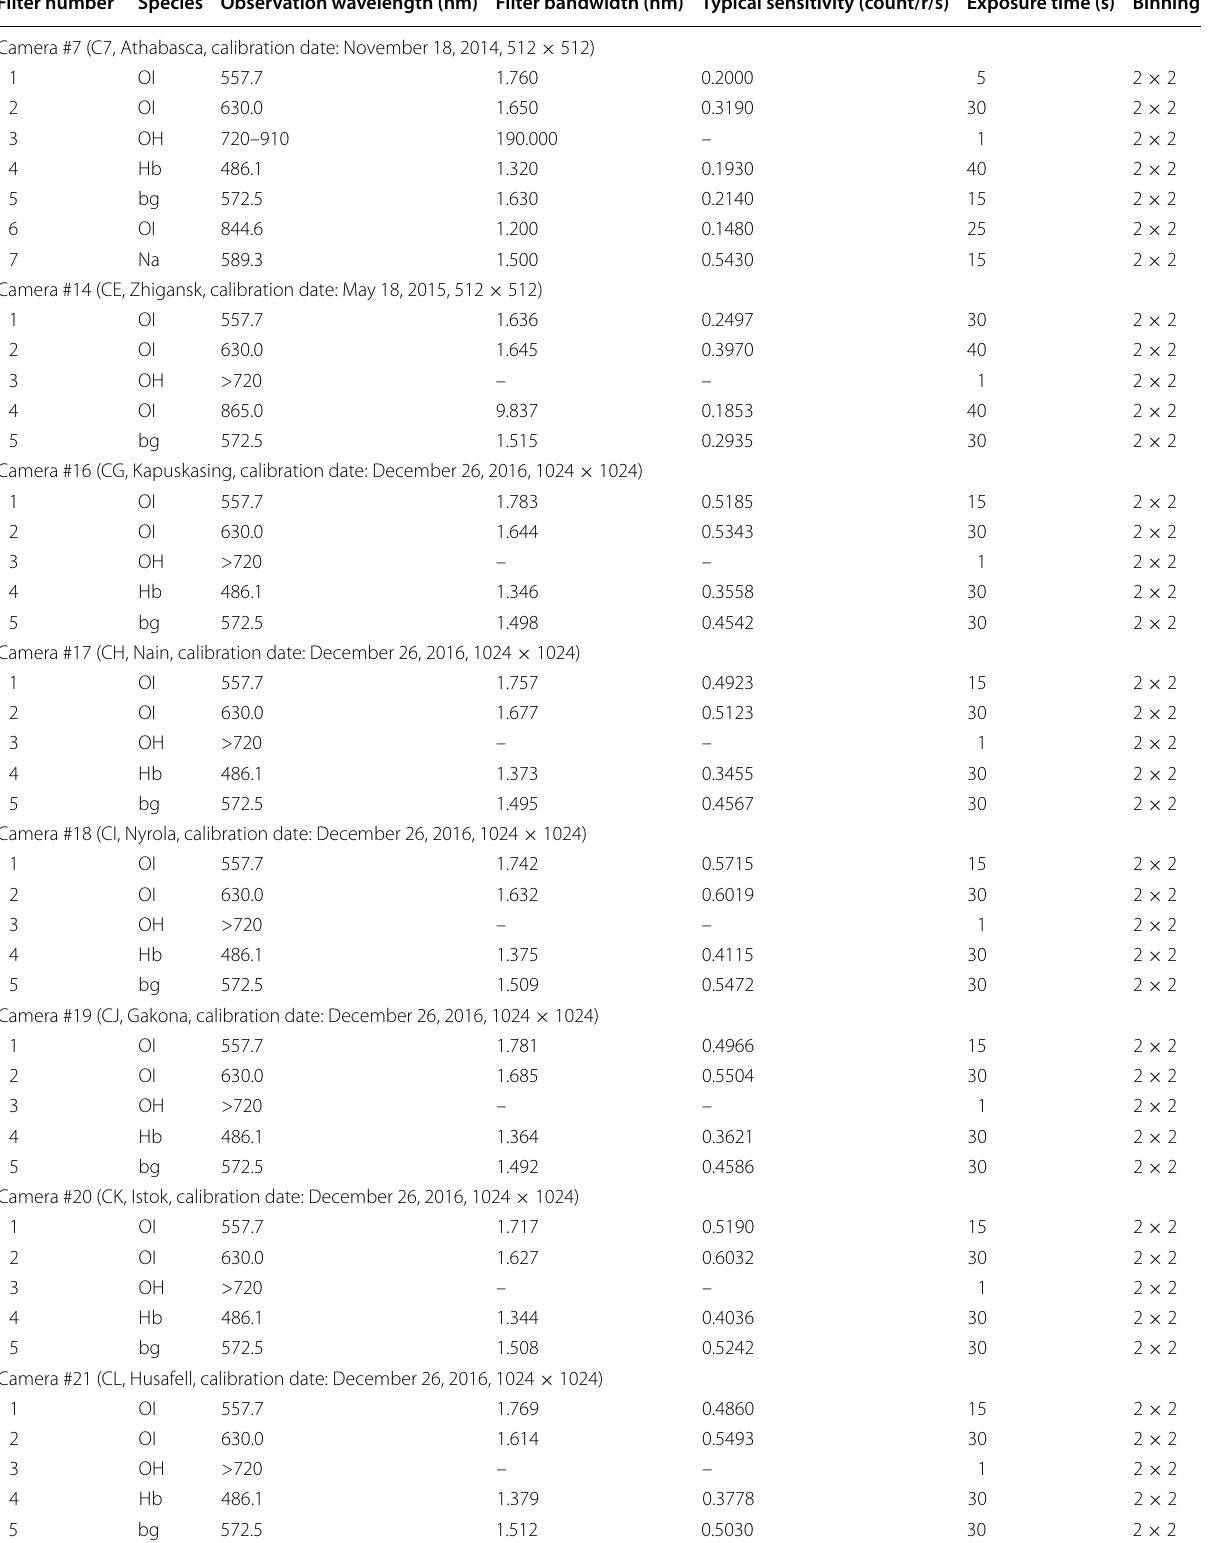
Table 2 Filter characteristics, typical sensitivities, and exposure times of the all-sky